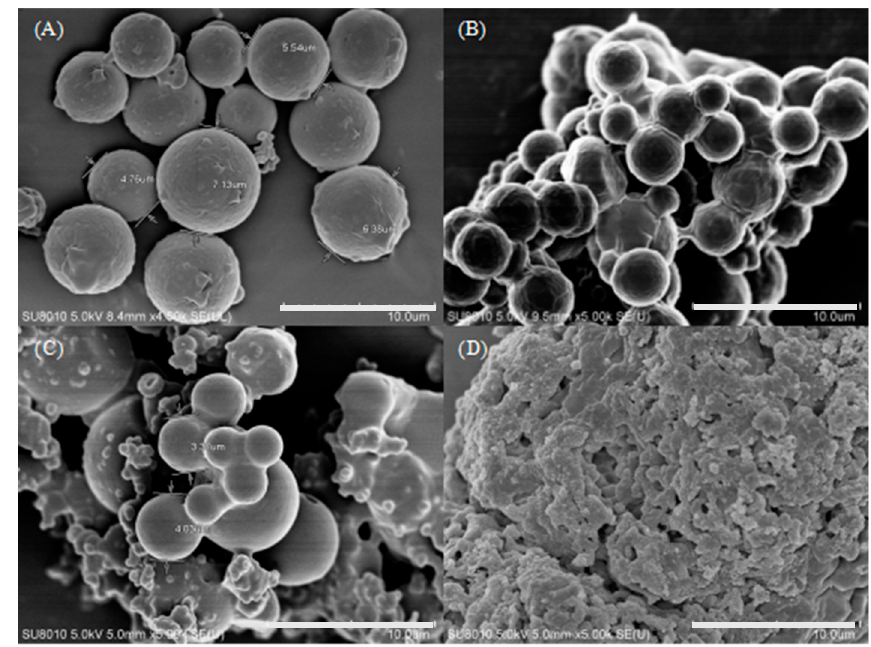
Figure 8. SEM images of microcapsules prepared with different amount of crosslinker. 0.25 wt% ( A ), 0.35 wt% ( B ), 0.5 wt% ( C ), 1 wt% ( D ). The scale bars are all 10 µ m.